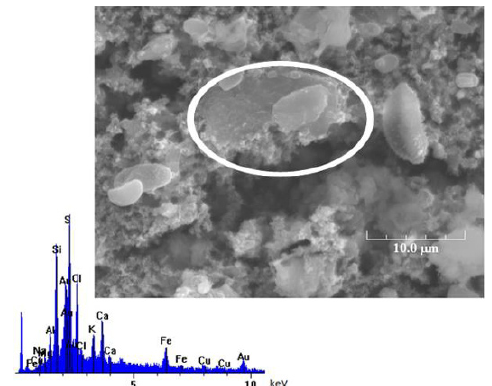
Figure 11. Dust sample from Gdansk (collected on 13.06.2006), the view of Na-rich particle and EDX spectrum